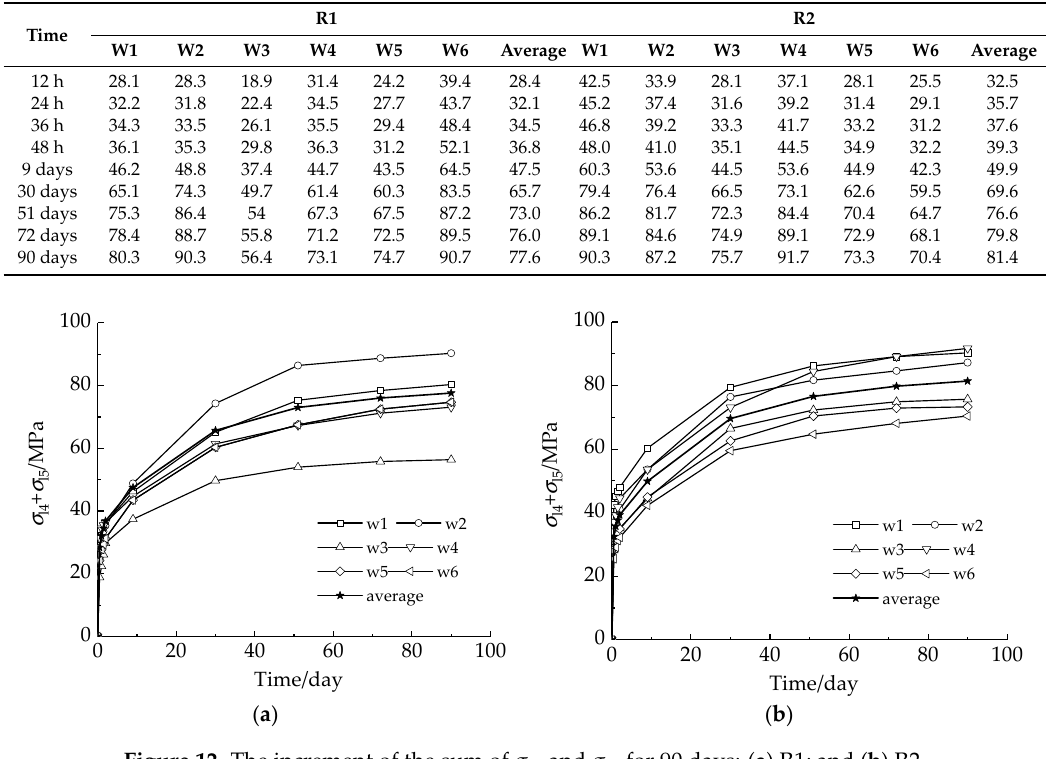
Figure 11. The increment of the sum of σ l4 and σ l5 for 90 days: ( a ) R1; and ( b ) R2. Figure 12. The increment of the sum of σ l4 and σ l5 for 90 days: ( a ) R1; and ( b )